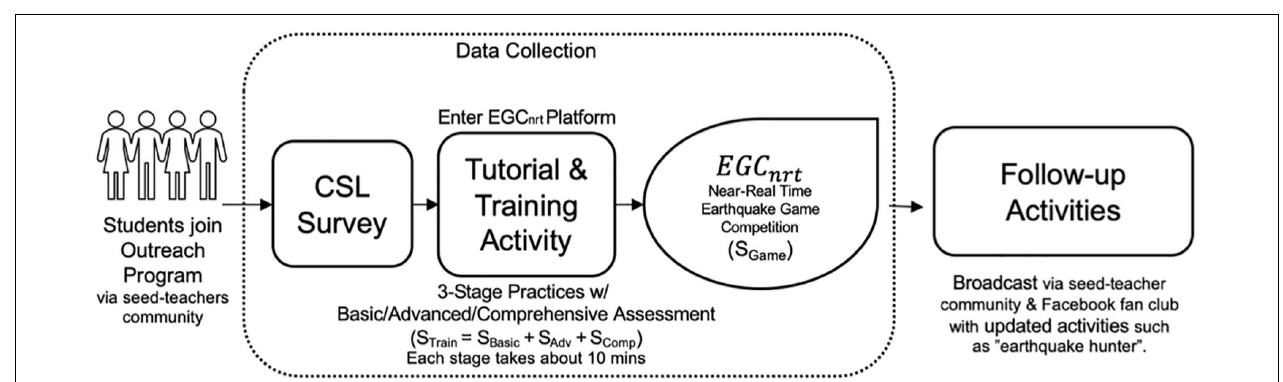
FIGURE 6 | Flowchart of a 1.5 h long EGCnrt program at schools. This program is composed of CSL survey, training activity (four certificate games), and near-real time earthquake game competition. The tutorial in training activity only takes 5 min for introducing the structure and function of the EGCnrt platform.